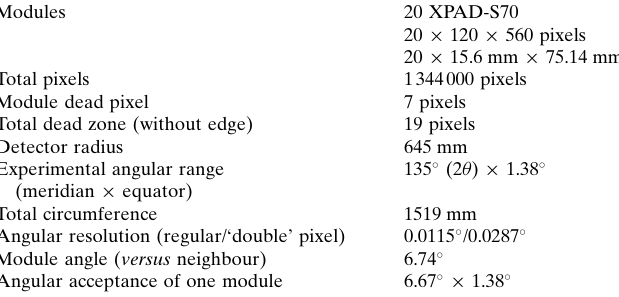
Table 2 Main characteristics of the